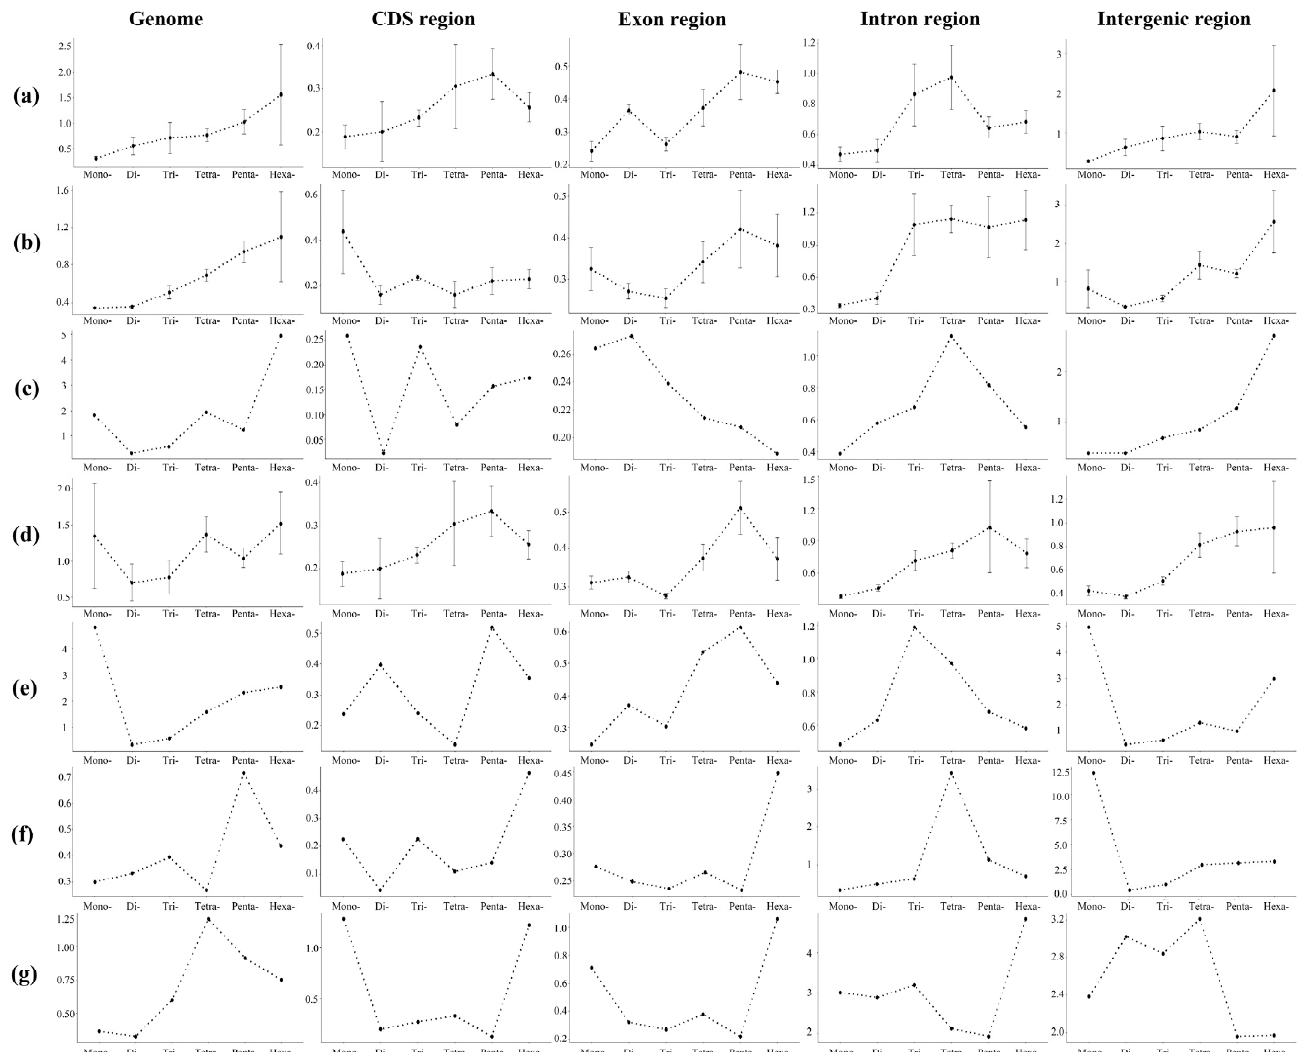
Figure 7. The coefficient of variability analysis of the repeat copy number of P-SSRs among six orders. ( a ) All; ( b ) Anseriformes; ( c ) Apodiformes; ( d ) Falconiformes; ( e ) Galliformes; ( f ) Passeriformes; ( g ) Psittaciformes.